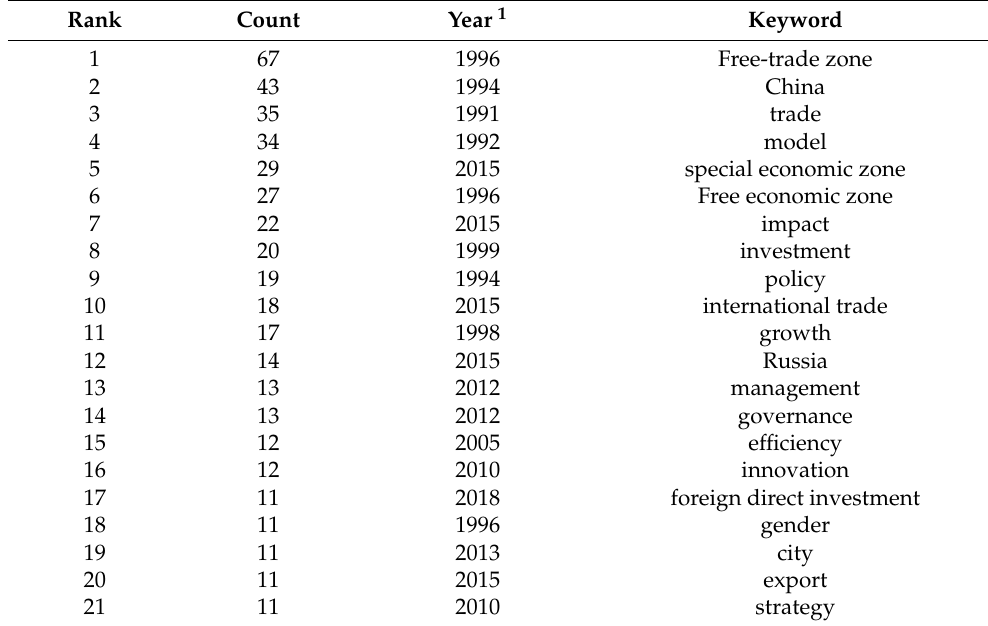
Figure 10. FTZ’s co ‐ occurrence knowledge map on keyword. (Note: Figure 10 is generated by the authors using CiteSpace, which is a free software that has been authorized for academic uses (see http://cluster.cis.drexel.edu/~cchen/citespace/, accessed on 21 April 2022)). Table 4. Keywords in high occurrence